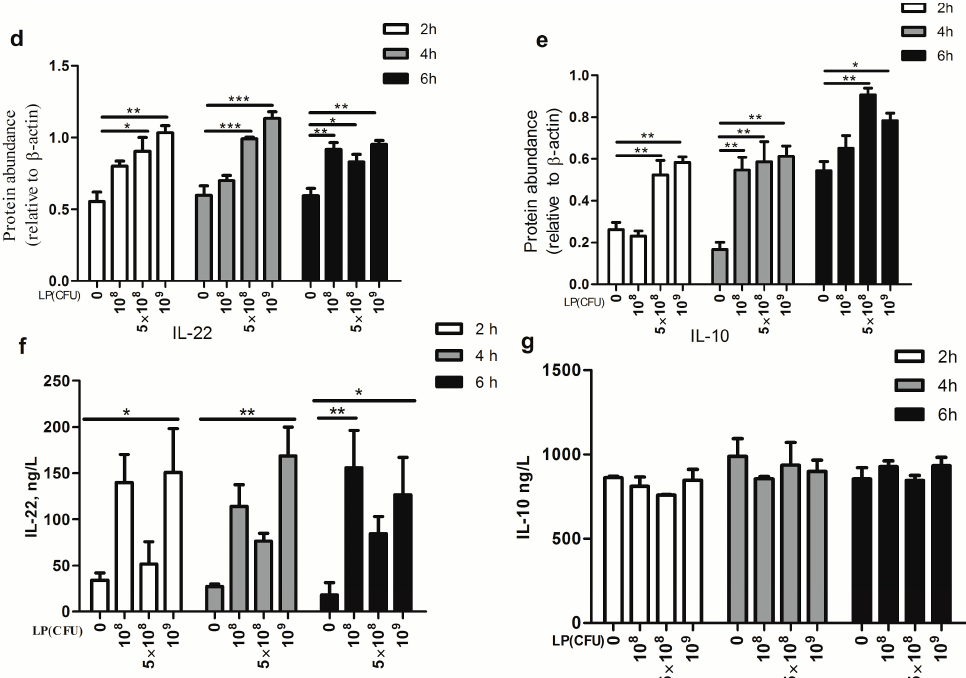
Figure 2. Effect of Lactobacillus plantarum (LP) on the expression of IL-22 and IL-10 in NK cells. NK cells were untreated or treated with LP (10 8 , 5 × 10 8 or 10 9 CFU/mL) for 2, 4, or 6 h. Cells were collected and the levels of IL-22 and IL-10 mRNA and protein were analyzed. ( a , b ) the relative transcript abundance of IL-10 and IL-22, respectively; ( c ) Western blot analysis of IL-22 and IL-10 protein. Loading and transfer of equal amounts of protein was confirmed by the immunodetection of β -actin; ( d , e ) the ratio of IL-22 and IL-10 to β -actin, respectively. Similar results were obtained from three independent experiments; ( f , g ) were the amount of IL-22 and IL-10 in media conditioned by NK cells, measured with IL-22 and IL-10-specific sandwich ELISAs. Data are means ± SEM. * p < 0.05, ** p < 0.01, *** p < 0.001.